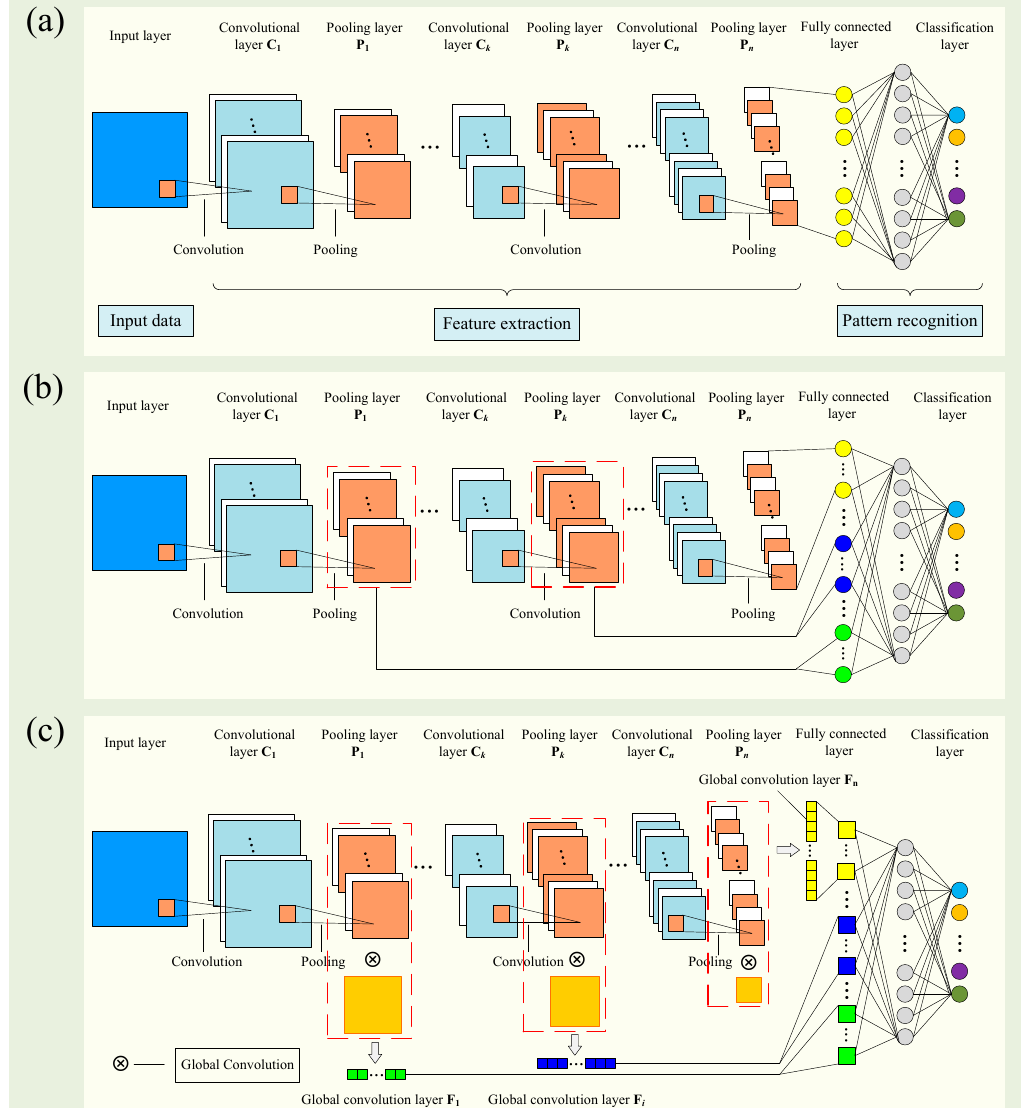
Figure 1. The framework of ( a ) a general convolutional neural network (CNN), ( b ) shallow information fusion-CNN and ( c ) simplified shallow information fusion-CNN.